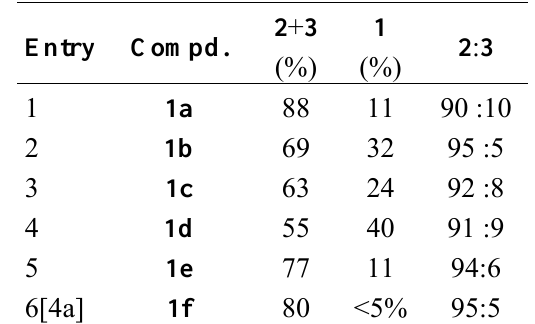
Table 1 . Hydroxy-selenenylation of compounds 1a - f .